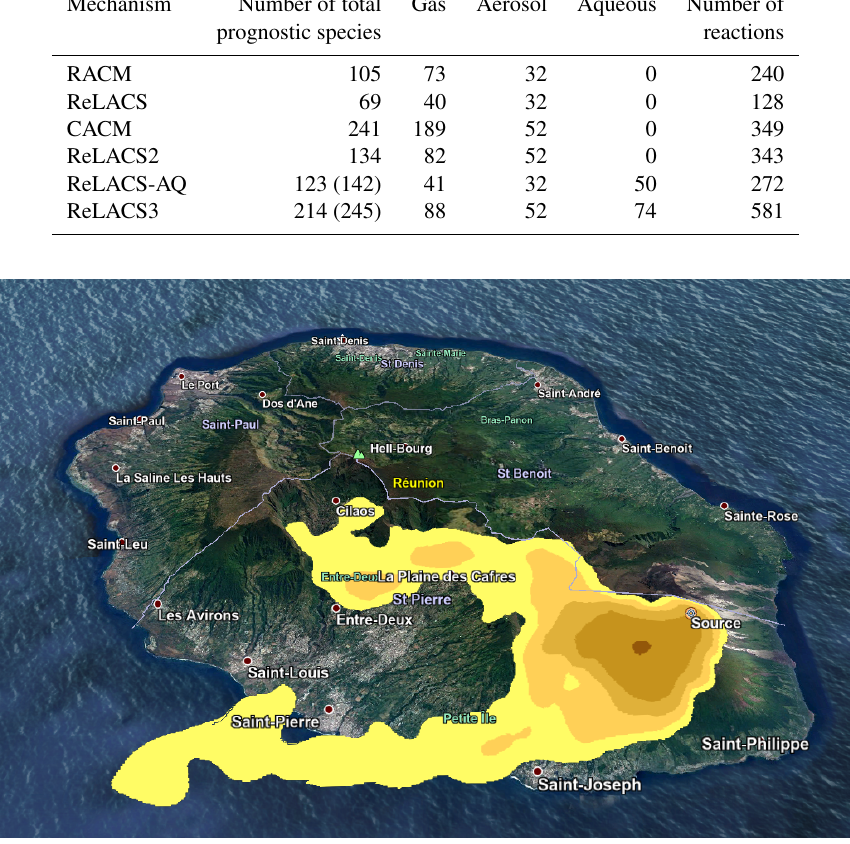
Figure 8. Atmospheric transfer coefficient (sm − 3 ) normalizing the concentration with the emission flow rate during the 6h following 00:00UTC on 18 May 2015 (isolines with logarithmic intervals from 10 − 14 to 10 − 9 sm − 3